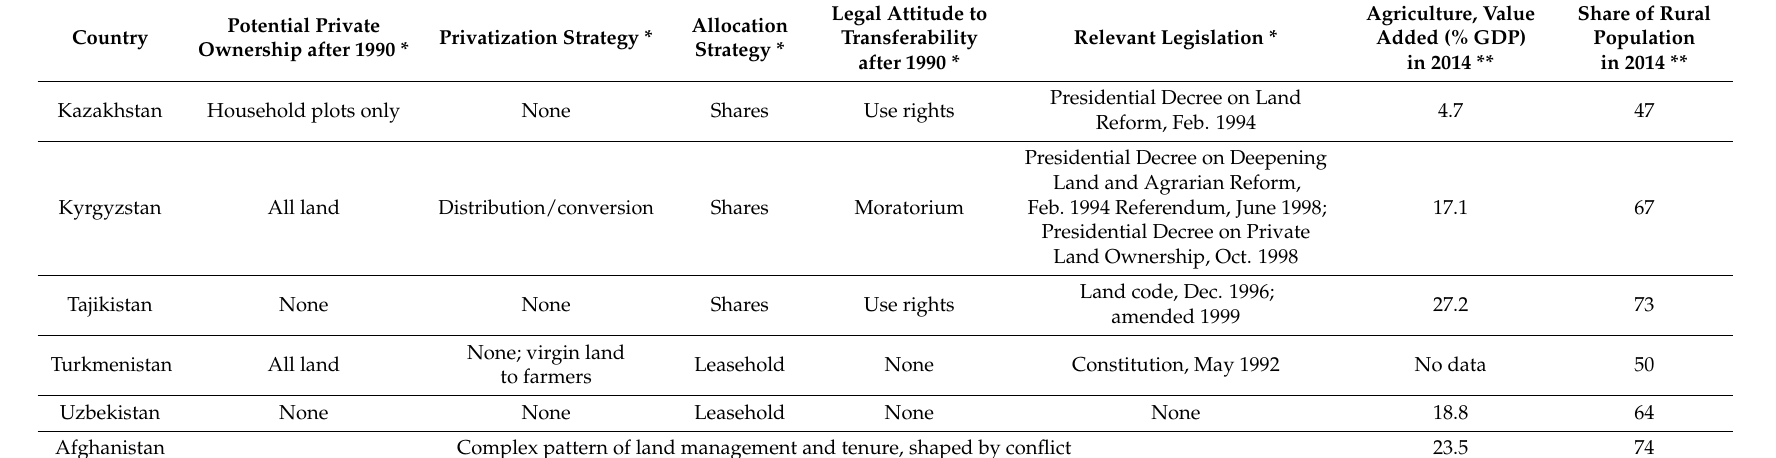
Table 1. Summary of the transition approaches across the post-Soviet countries within the Aral Sea Basin.